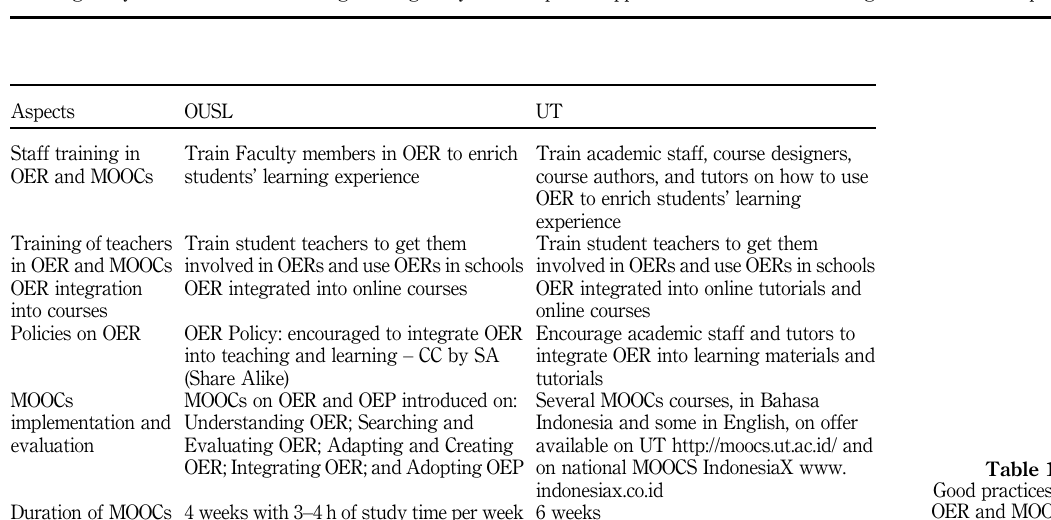
Table 16. Good practices